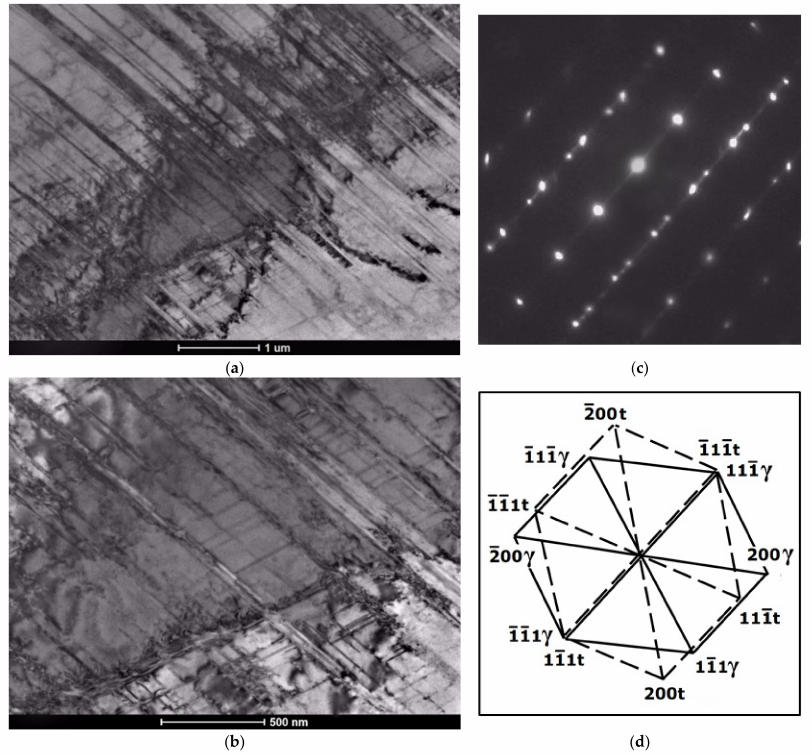
Figure 11. Mechanical twins on the background of austenite matrix after 30% deformation; bright field images ( a , b ) and SAED pattern with schematic representation ( c , d ).